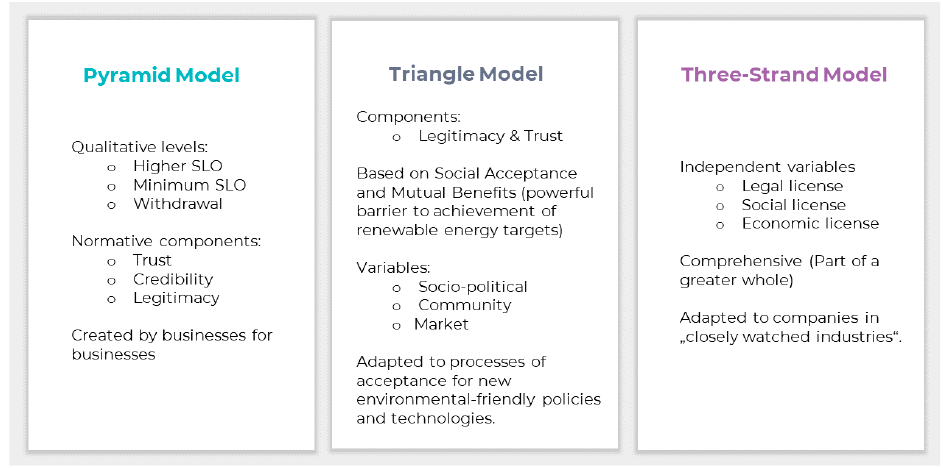
Figure 1. Structuring the SLO process: pyramid, triangle, and three-strand model characteristics. and Thomson [61]. This model is based on qualitative levels of SLO separated by boundaries